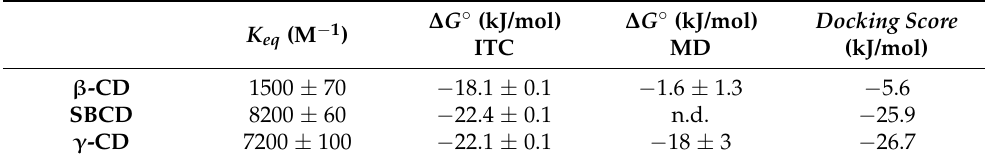
Table 2. Gibbs binding energy ( ∆ G ◦ ) values obtained by ITC and molecular dynamics (MD) and docking scores for the formation of inclusion complexes between VTD and the studied CD hosts.